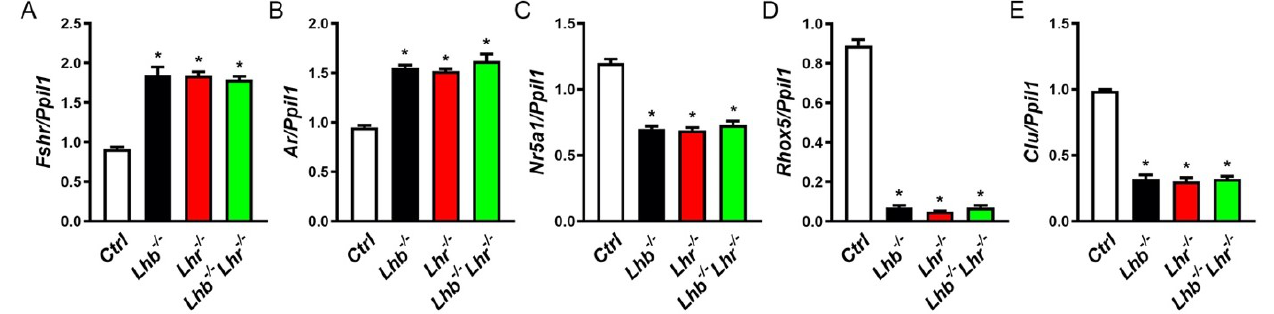
Figure 5. Taqman qPCR analysis of Sertoli cell marker genes. T-repressed genes namely, Fshr ( A ) and Ar ( B ) are upregulated in the absence of LH or LHR or both. In contrast, those that are positively regulated by T, such as Nr5a1 , Rhox5 and Clu are similarly suppressed in the absence of LH or LHR or both ( C-E ). * p < 0.05, One -way ANOVA, Ctrl vs. Lhb − / − or Lhr − / − or Lhb − / − Lhr − / − ; p > 0.05, One- way ANOVA, Lhb − / − vs. Lhr − / − or Lhb − / − Lhr − / − ; Lhr − / − vs. Lhb − / − Lhr − / − . For all qPCR assays, expression of Ppil1 was used as internal control and cDNA samples in triplicate were used from testis obtained from 3 mice.